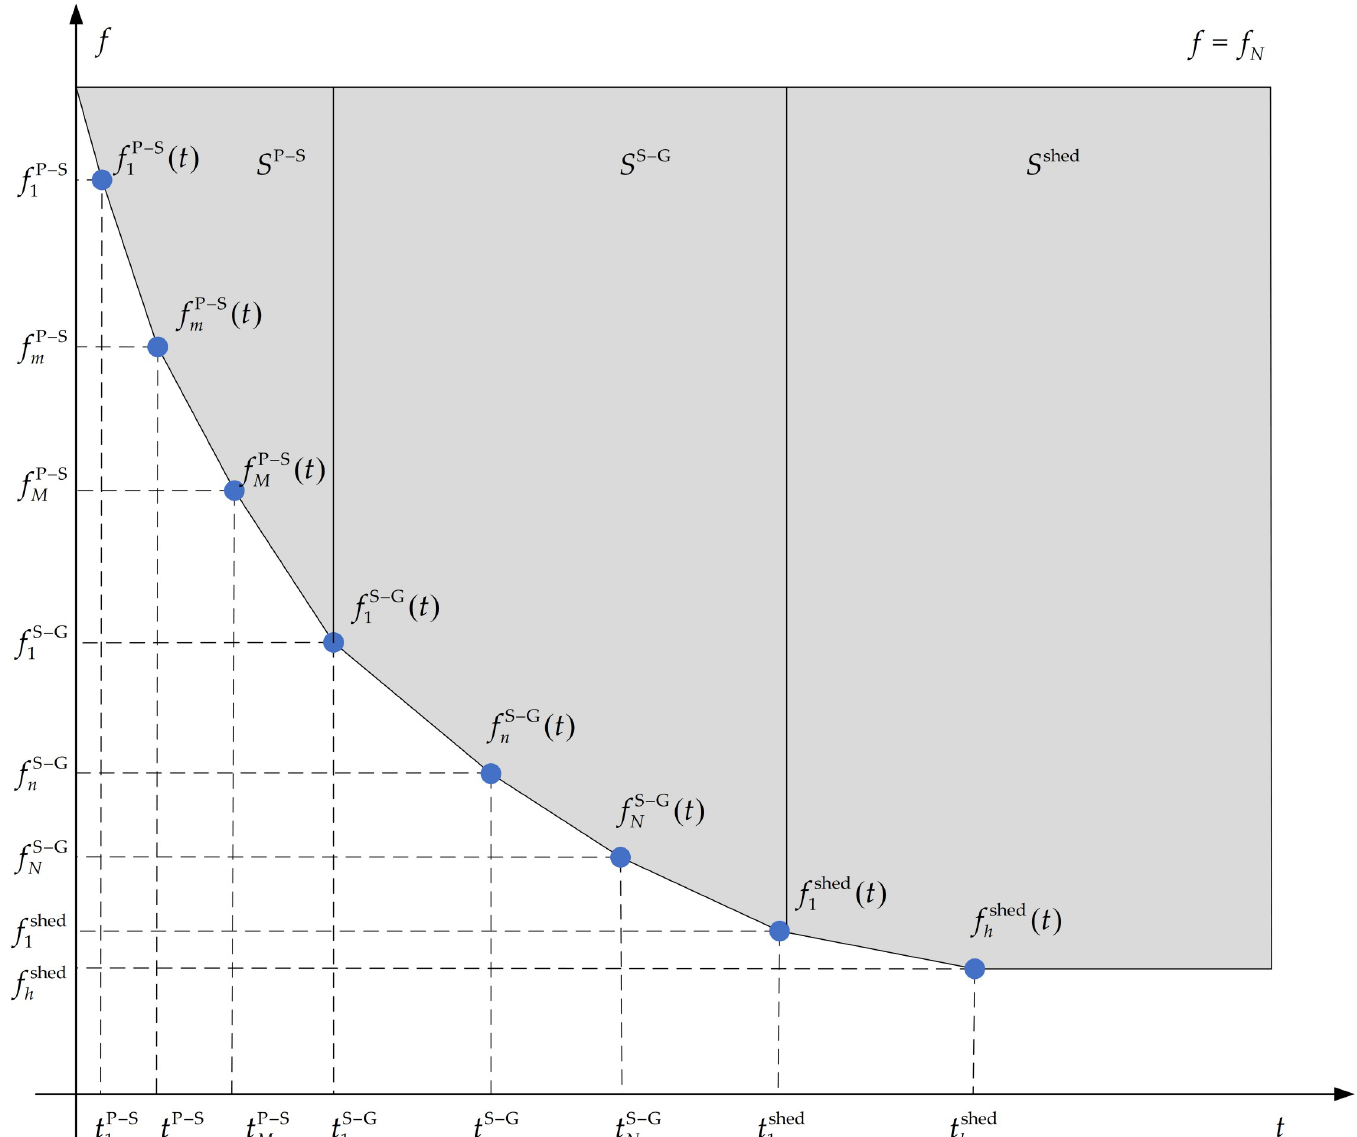
Fig 5. The dynamic frequency trajectory curve for the combined system of pumped storage units and